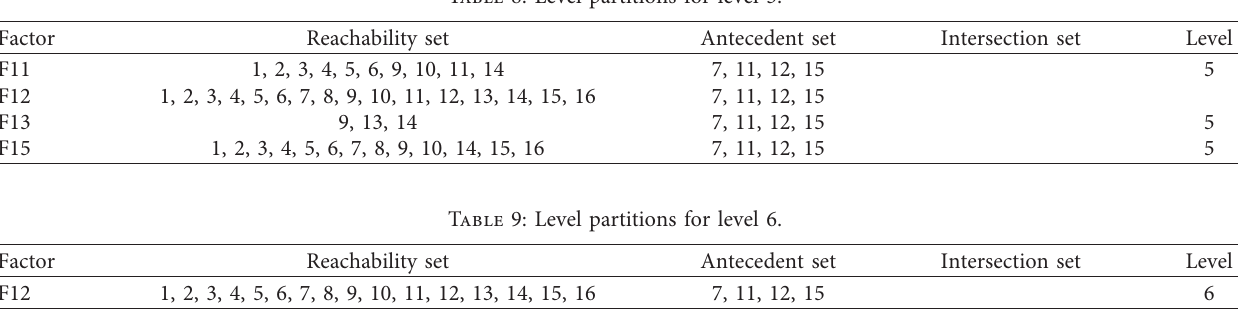
Table 8: Level partitions for level 5.